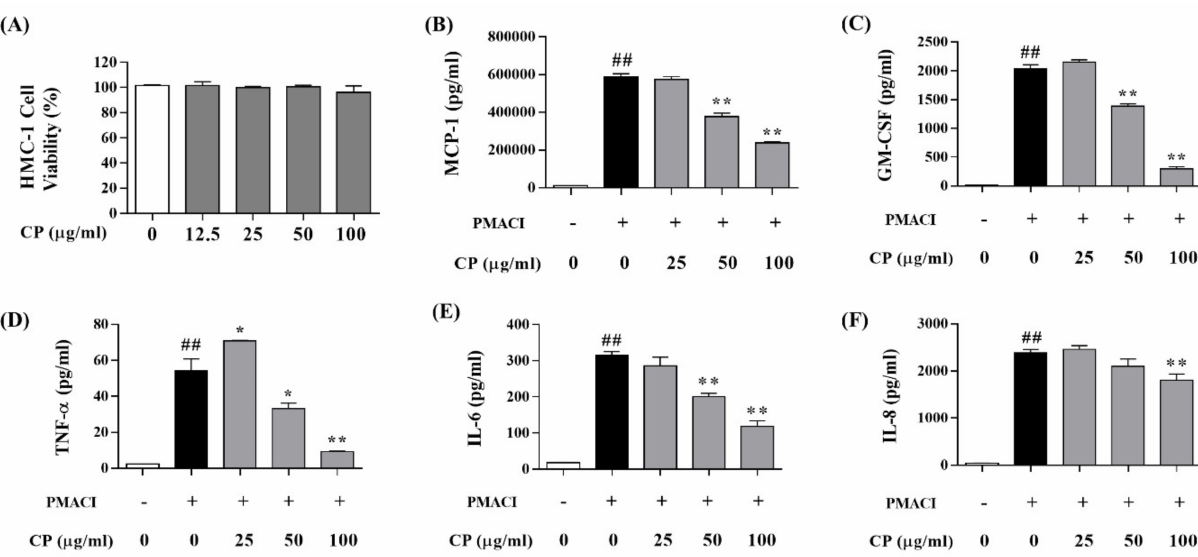
Figure 3. Effect of CP on phorbol-12-myristate-13-acetate plus A23187 (PMACI)-stimulated HMC-1 cells. ( A ) Viability of CP in HMC-1 cell by MTS assay. HMC-1 cells were treated with different concentrations of CP (0, 12.5, 25, 50 and 100 µ g/mL) for 24 h. ( B – F ) Inflammatory cytokine expression in PMACI-stimulated HMC-1 cells. The cells were treated with the different concentrations of CP (25, 50 and 100 µ g/mL) for 1 h and then treated with PMACI for 7 h. Absorbance was measured using a microplate reader at 490 nm. All data represent the means ± SEM ( ## p < 0.01 vs. TNF- α /IFN- γ non-treat group. * p < 0.05 and ** p < 0.01 vs. only TNF- α /IFN- γ -treat